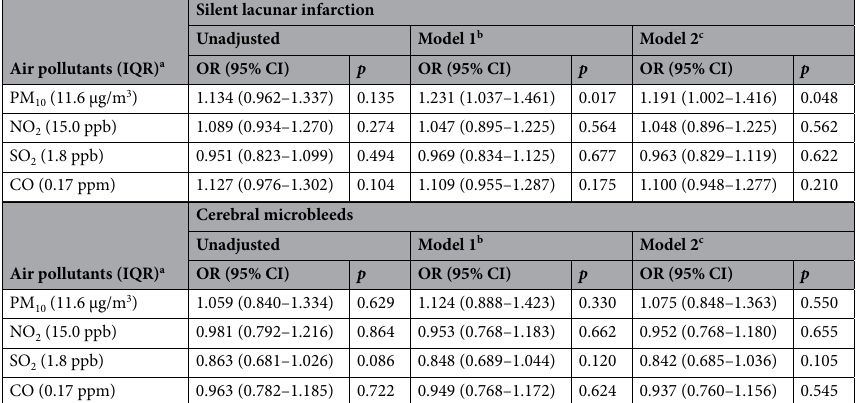
Table 3. Logistic regression analysis results for the association between silent lacunar infarction, cerebral microbleeds, and air pollution. IQR, interquartile range; OR, odds ratio; CI, confidence interval; PM 10 , particulate matter ≤ 10 μm in diameter; NO 2 , nitrogen dioxide; SO 2 , sulfur dioxide; CO, carbon monoxide. a The odds ratio and 95% confidence interval in each air pollutant was scaled to the interquartile range for each pollutant, respectively (11.6 μg/m 3 for PM 10 , 15.0 ppb for NO 2 , 1.8 ppb for SO 2 , and 0.17 ppm for CO). b Model 1 was adjusted for age, sex, body mass index. c Model 2 was adjusted for Model 1 plus hypertension, diabetes mellitus, and